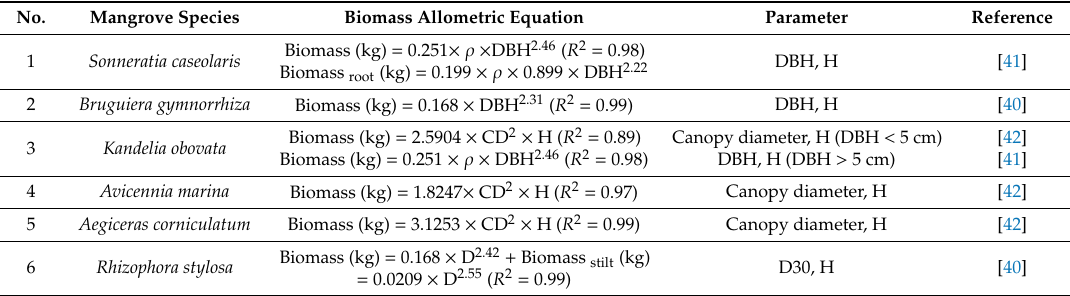
Table 2. Allometric equations for each mangrove species in the study area.